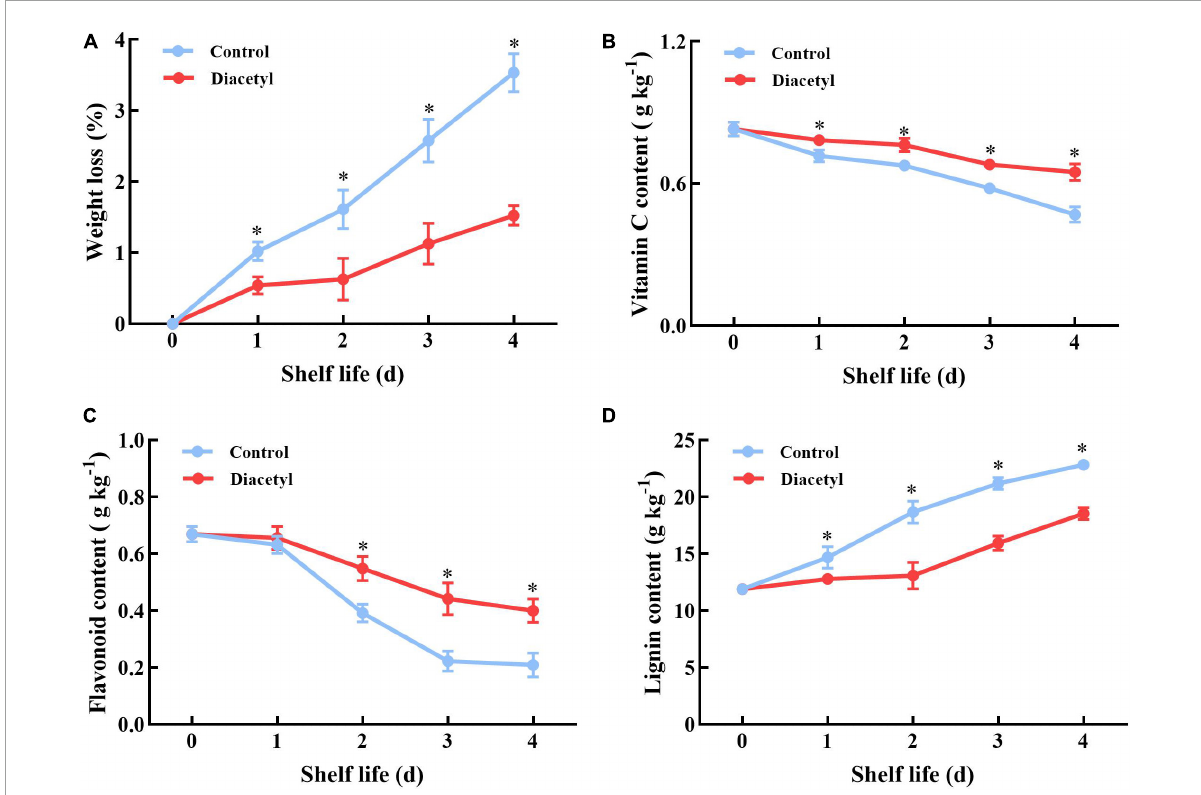
FIGURE2 Diacetyl reduced the weight loss (A) and inhibited the decrease in the contents of vitamin C (B) and flavonoid (C) and the increase in the lignin content (D) in broccoli florets during shelf life. Data are the average of three replicates ± SD. Asterisk ( ∗ ) indicates a significant difference among the control and diacetyl treatment groups at the same time at P <